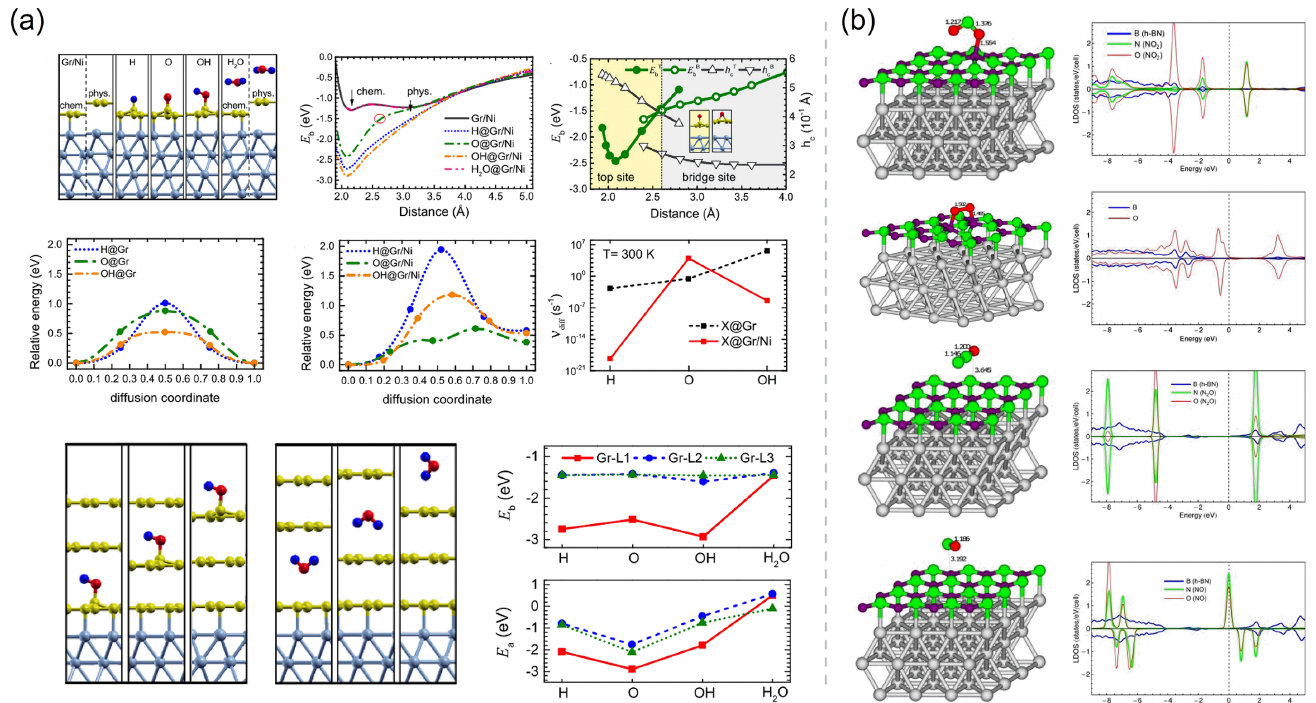
Figure 7. ( a ) Optimized structures, interface binding energies ( E b ), adsorption energy ( E a ), minimum energy paths for the diffusions, and diffusion rates of adsorbates (H, O, OH, H 2 O) on monolayer Gr/Ni and trilayer Gr/Ni. Adapted with permission from Reference [93]. Copyright 2021, Elsevier. ( b ) Optimized structures and calculated spin-resolved projected density of states of NO 2 , O 2 , N 2 O, and NO on h-BN/Ni(111). Adapted with permission from Reference [135]. Copyright 2014,